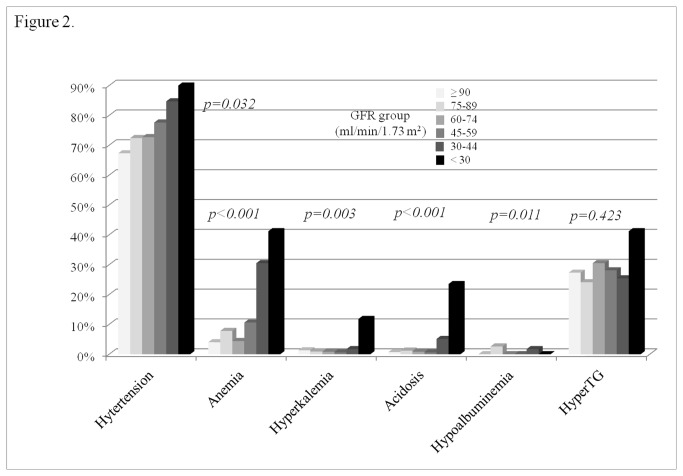
The prevalence of complications related to renal dysfunction.P-value calculated by Pearson’s Chi-square test. HyperTG: hypertriglyceridemia.